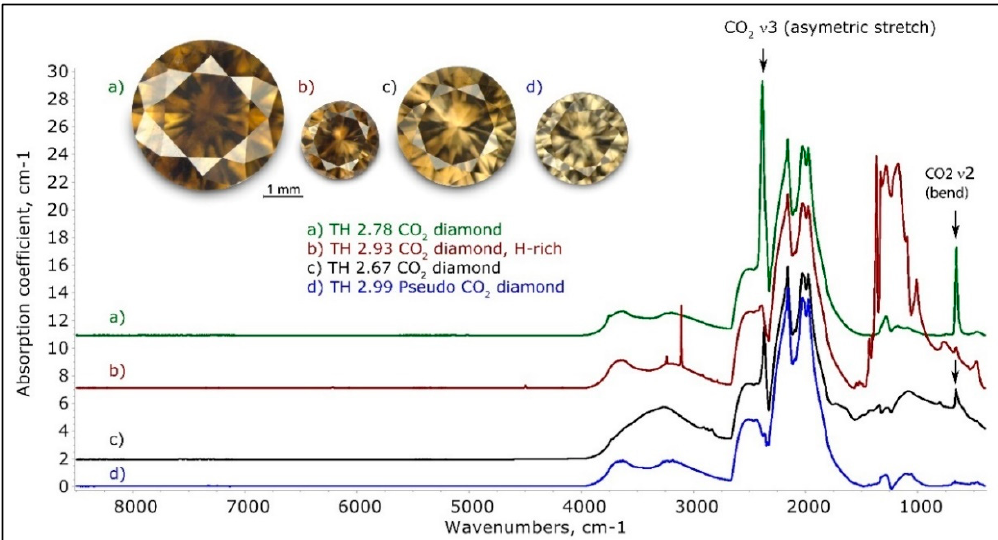
Figure 5. A few representative normalized IR spectra of brown CO 2 and Pseudo CO 2 diamonds. Trace ( a ) is a typical CO 2 diamond spectrum, spectrum ( b ) a very unusual hydrogen and nitrogen-rich CO 2 diamond, and trace ( c ) an example of a CO 2 diamond not exhibiting any trace of known nitrogen-related absorptions. Trace ( d ) is a typical Pseudo-CO 2 diamond, but it must be mentioned that these spectra vary widely; they may exhibit some known nitrogen-related absorptions but generally a significant portion of the one-phonon absorption is of unknown cause. The spectra have been shifted vertically for